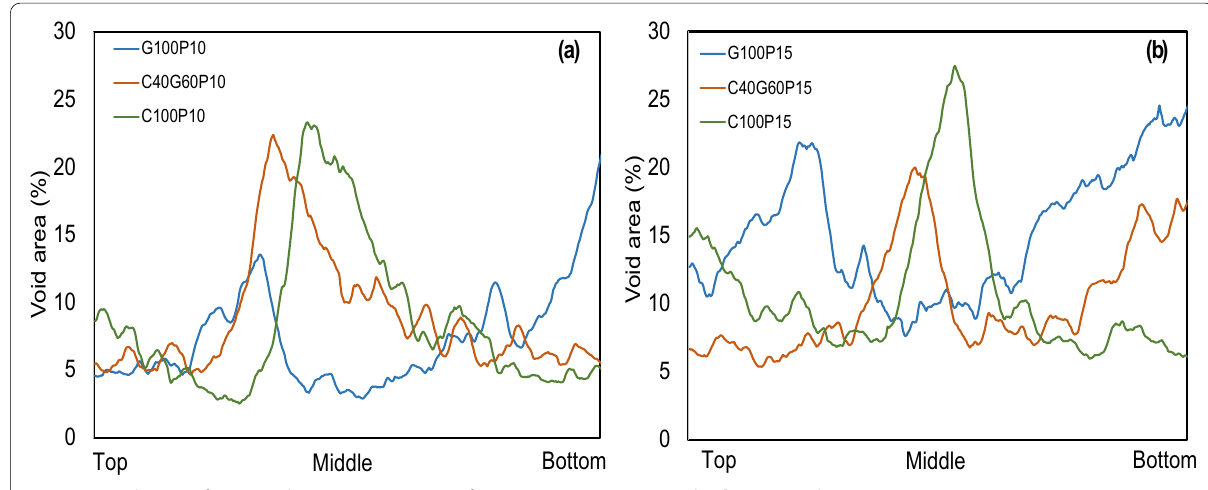
Fig. 15 Distribution of pores in the pervious concretes from CT images: a P10 samples; b P15 samples.